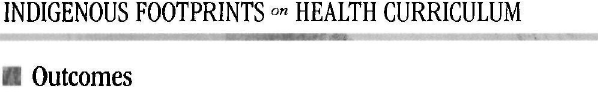
Table 2. Graduated model to move students from cultural awareness to competence over the duration of their degree. Components